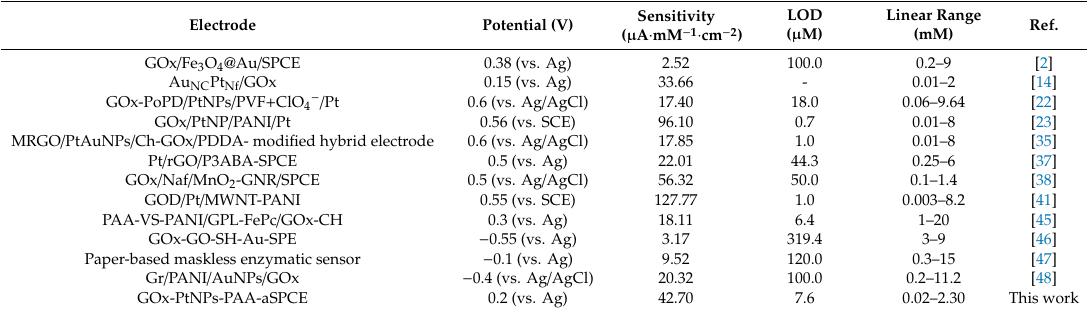
Table 1. Electroanalytical parameters of glucose determination for a variety of enzymatic biosensors based on GOx.